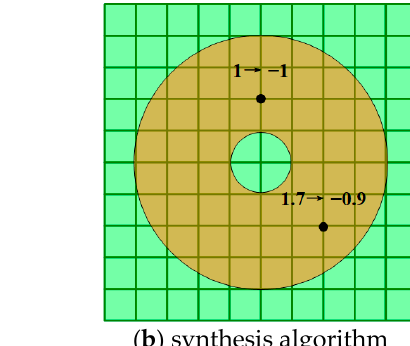
Figure 9. Comparison the burning surface area of the synthesis algorithm and LS algorithm in NAWC No. 6 partial grain. 4.3. Tube Grain A computational simulation of tube grain under erosive burning effect was per- formed using the synthesis algorithm. It can be visualized from Figure 10 that at the be- ginning of the burning phase, the overall motor burning rate is high and the erosive burn- ing effect is obvious. In the late stage of the burning, the gas channel shows a small front and large rear cone, and the erosive burning effect almost disappears. Although the ero- sive burning effect disappears in the later stages of the work, the conical channel formed